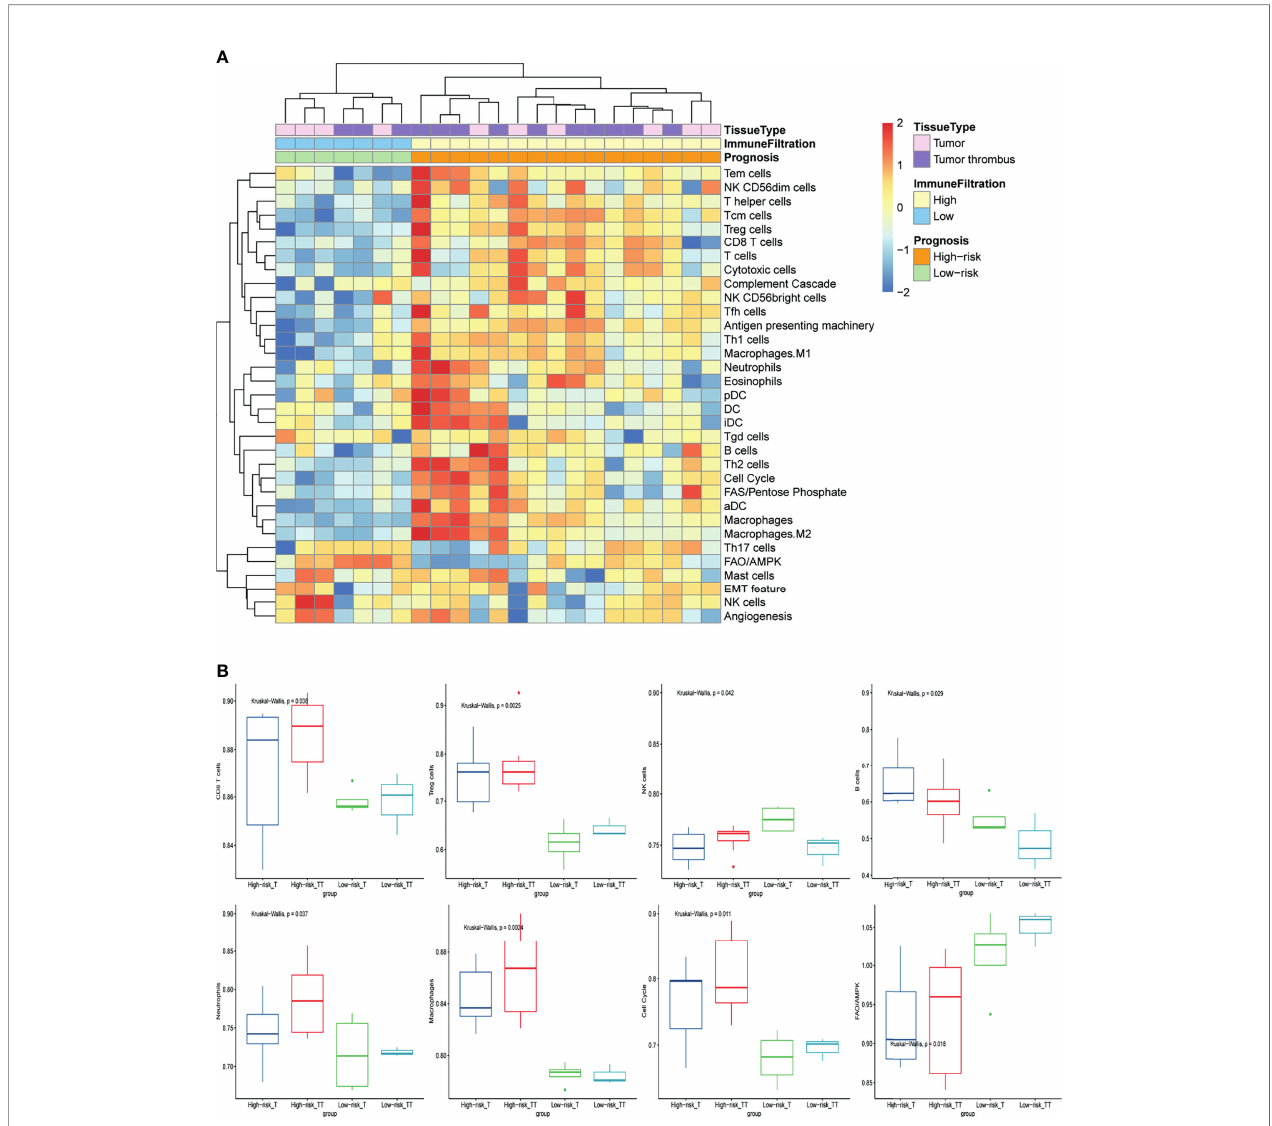
FIGURE 1 | The immune-oncology landscape of localized RCC with tumor thrombus. (A) Heatmap of the ssGSEA score, as estimated using gene sets for immune cells and classic oncologic pathways. The top bar indicates the groups strati fi ed by the tissue of tumor or tumor thrombus, the second bar indicates the immune cell in fi ltration group, and the third bar on the x-axis represents the prognosis of the patients. (B) The average expression of cell cycle and FAO/AMPK signaling and changes in the constituent ratios of in fi ltrated cell subpopulations including CD8 T cells, Treg cells, NK cells, B cells, neutrophils, and macrophages in the four subgroups for “ High-risk ” or “ Low-risk ” group of tumor or tumor thrombus. Data were analyzed using the Kruskal-Wallis test. High-risk_T, tumor tissue in the “ High- risk ” group; High-risk_TT, tumor thrombus tissue in the “ High-risk ” group; Low-risk _T, tumor tissue in the “ Low-risk ” group; Low-risk_TT, tumor thrombus tissue in the “ Low-risk ”